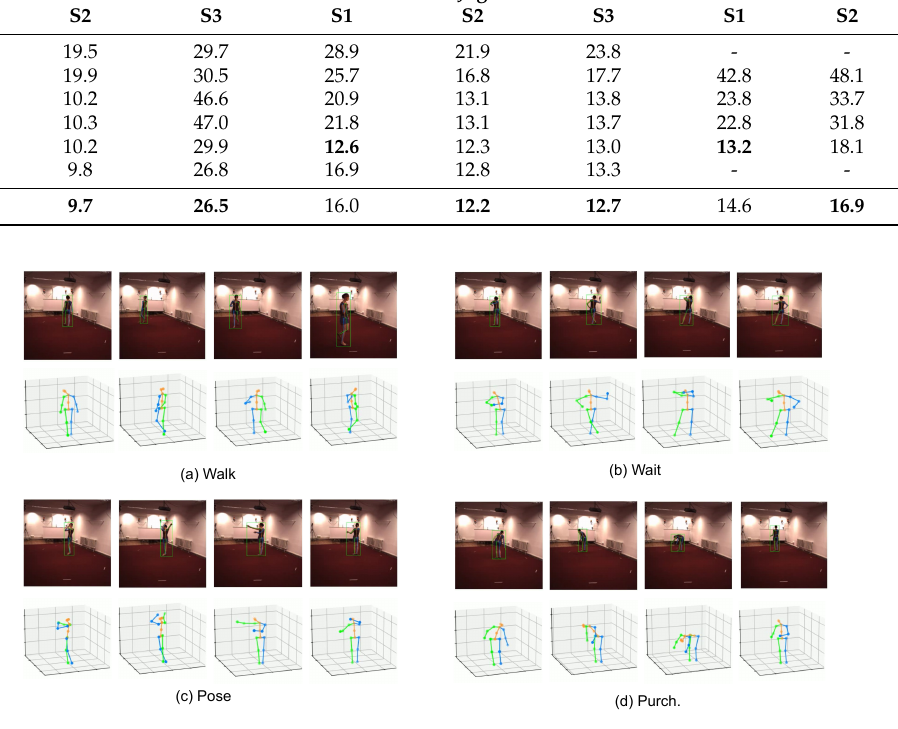
Figure 6. The visualized qualitative results of 3D pose estimation in